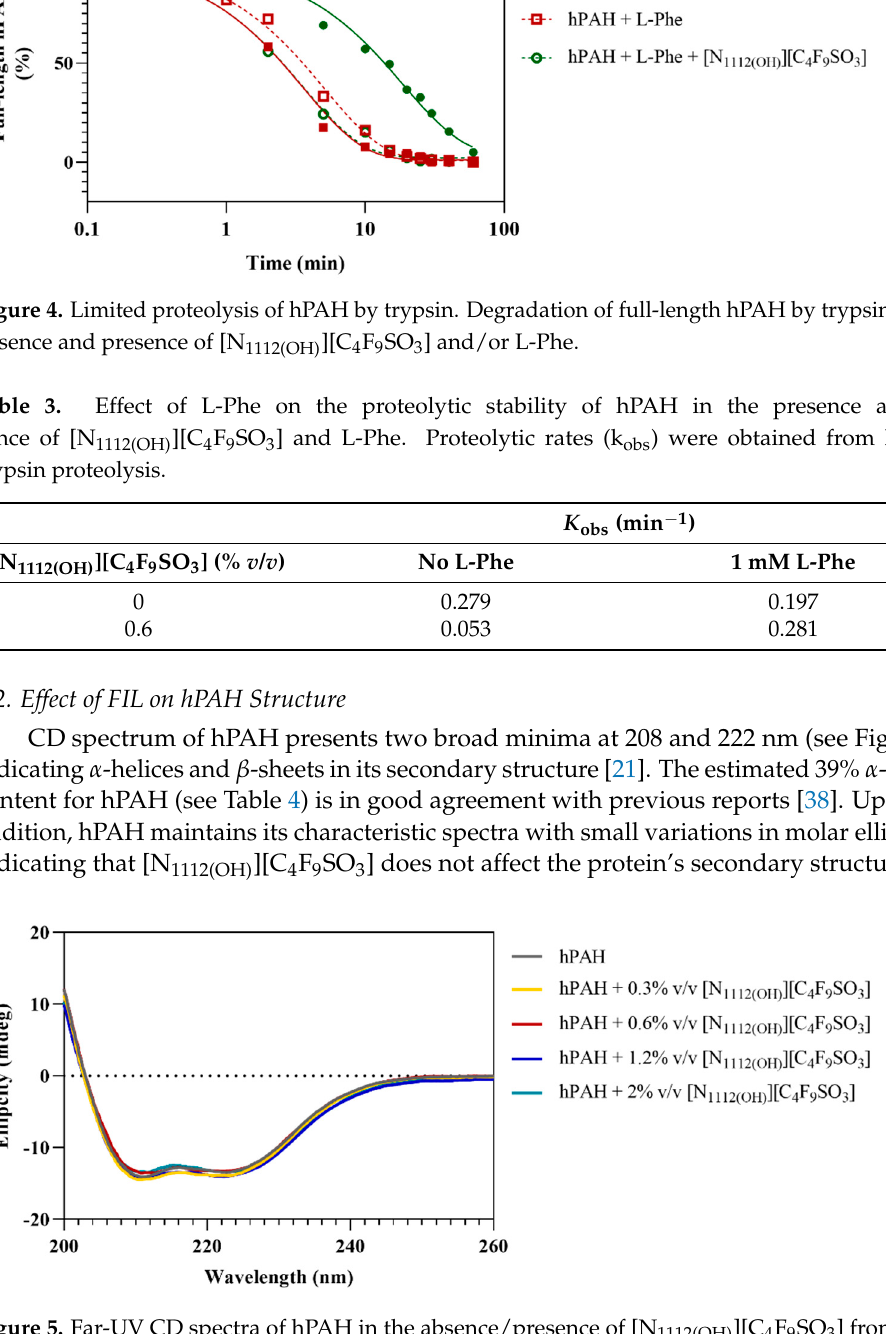
Figure 5. Far-UV CD spectra of hPAH in the absence/presence of [N 1112(OH) ][C 4 F 9 SO 3 ] from 0.3 to 2% v / v .